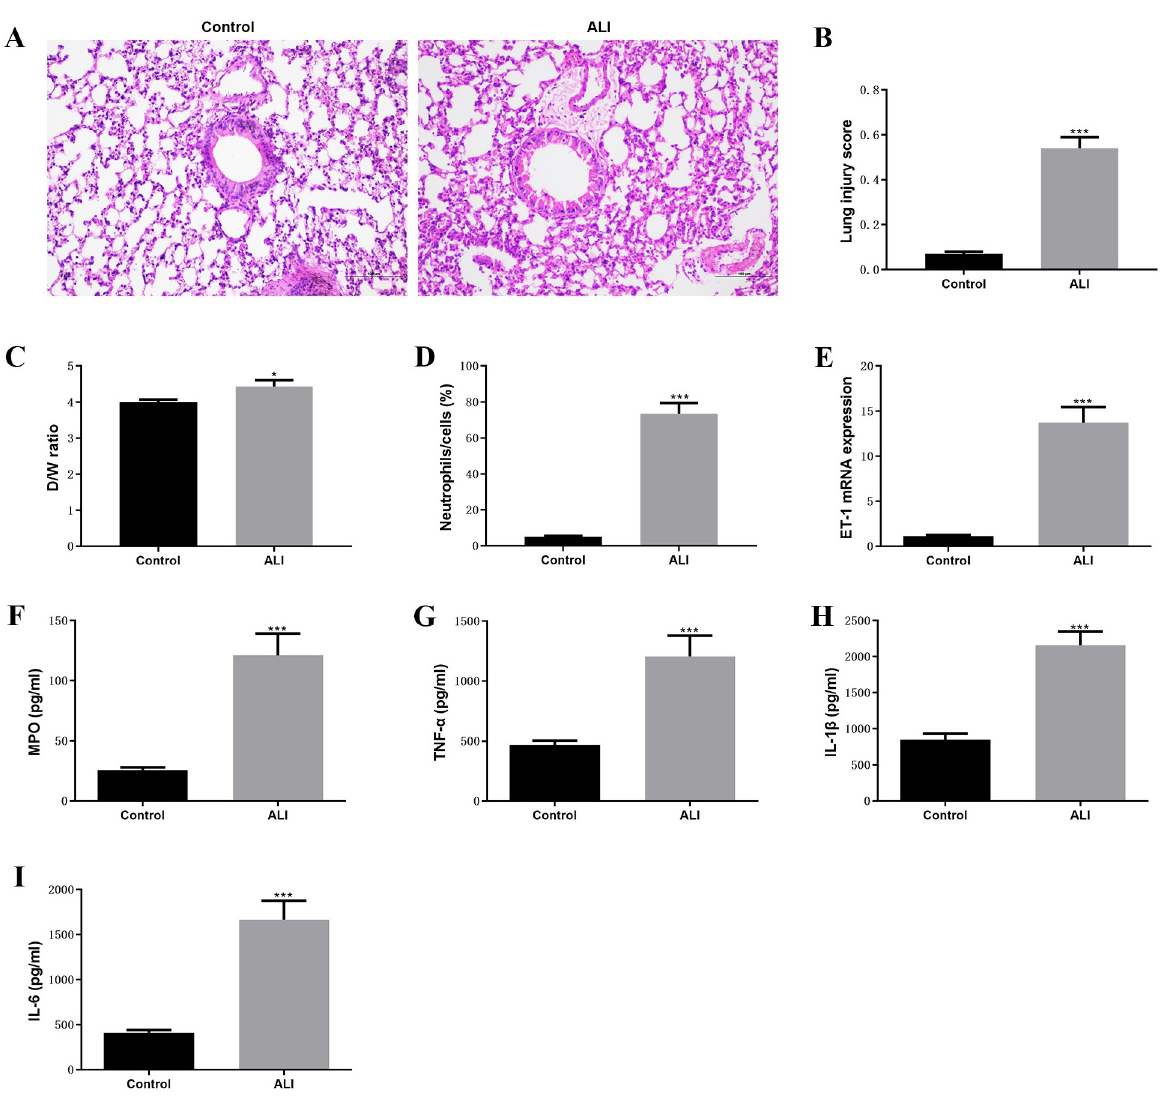
Fig 2. Established of LPS-induced ALI mouse model. (A)-(D) The histology of lung tissue calculated using H & E staining, lung injury score, D/ W ratio, and infiltrated neutrophils between ALI and control groups, respectively. (E) The mRNA expression of ET-1 between ALI and control groups were determined by RT-qPCR. (F)-(I) The levels of MPO, TNF- α , IL-1 β , and IL-6 between ALI and control groups were detected by ELISA assay. ��� P <